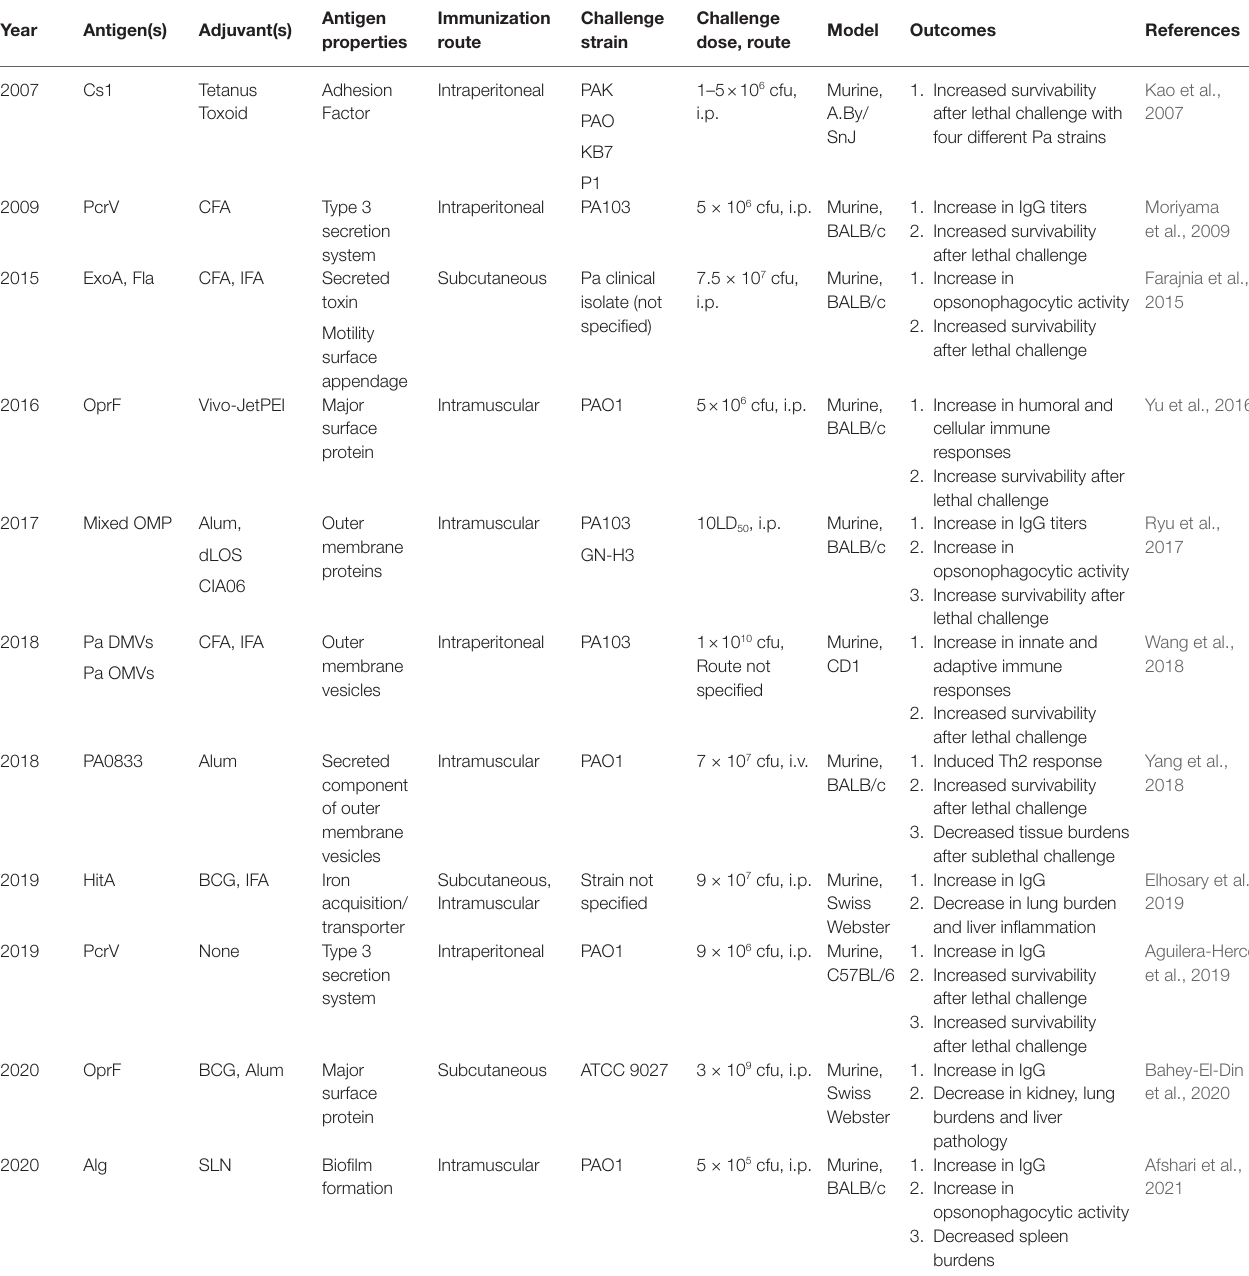
TABLE 1 | Vaccine candidates evaluated against Pa bloodstream